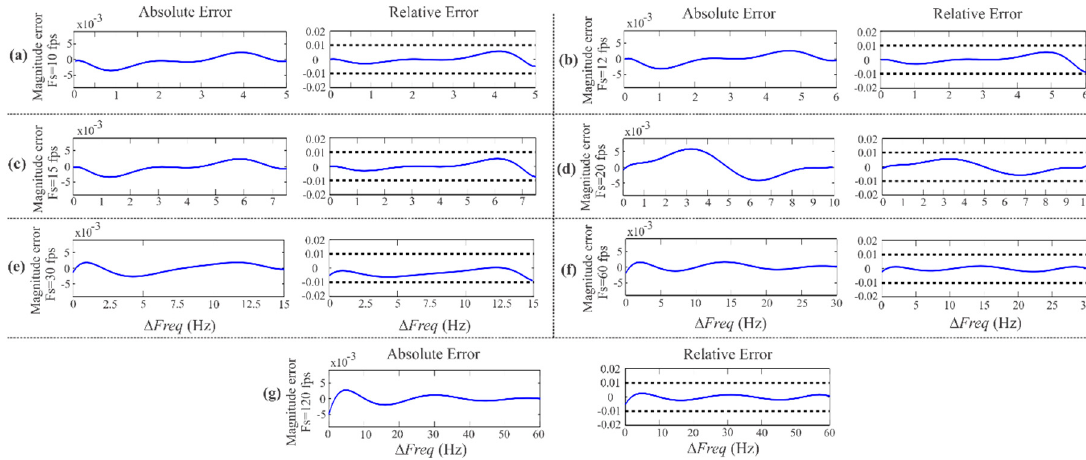
Figure 4. Absolute and relative errors for: ( a ) 10 fps, ( b ) 12 fps, ( c ) 15 fps, ( d ) 20 fps, ( e ) 30 fps, ( f ) 60 fps and ( g ) 120 fps.